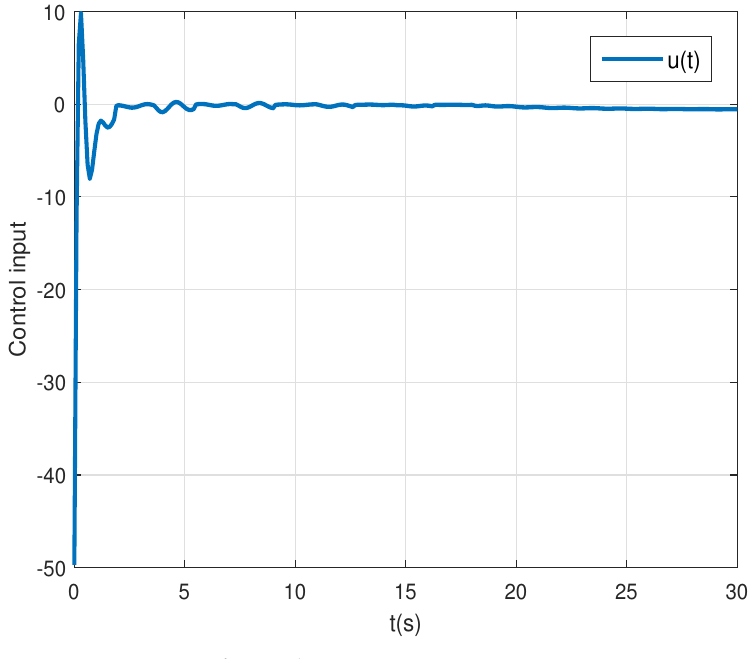
Figure 5. Dynamics of control input.